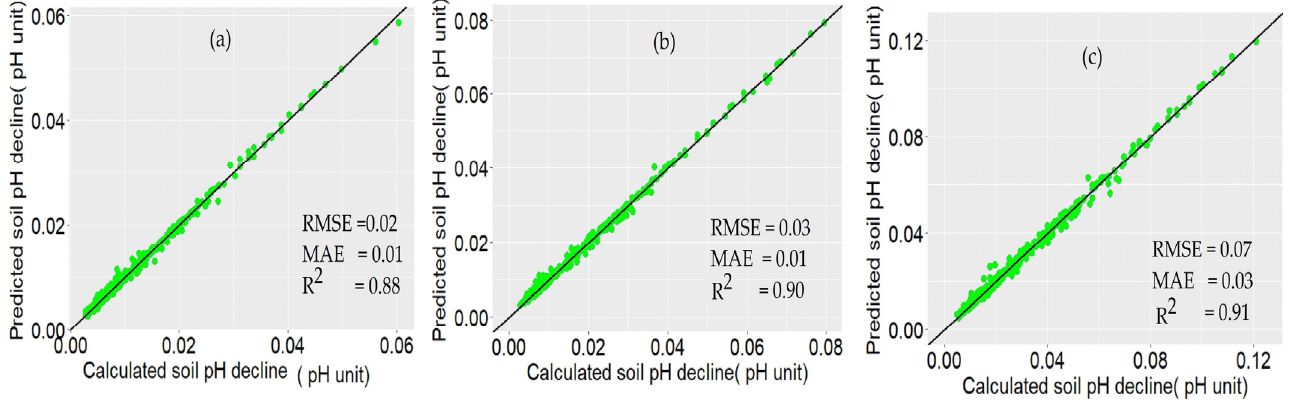
Figure 8. Density scatters plots of predicted against observed soil pH decline using ensemble machine learning: cross-validation results for mean annual pH decline for ( a ) 1980–2022, ( b ) 2022–2050 in the BAU scenario, and ( c ) 2022–2050 in the EqD scenario. The black line is the 1:1 line. MAE: mean absolute error; RMSE: root mean square error; R 2 : coefficient of determination for 1980 to 2050. For S1, S2, and S3, see the cross-validation results in Table S5.